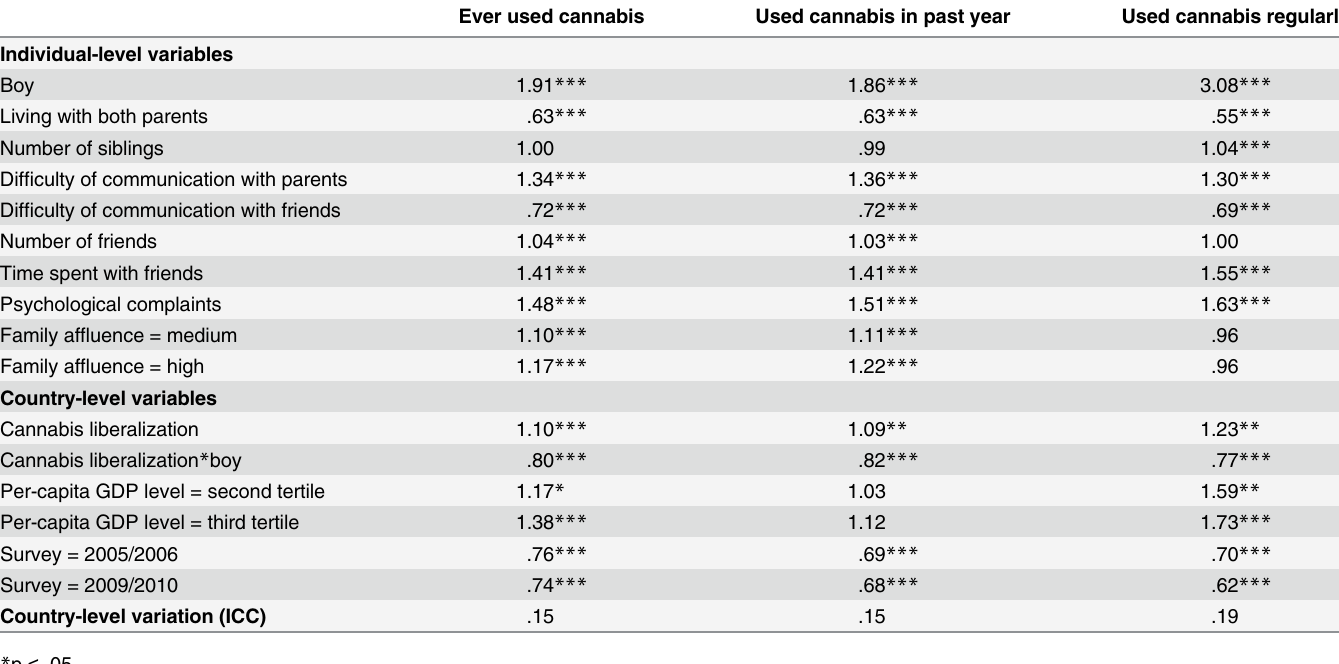
Table 3. Multilevel logistic regressions for adolescent cannabis use status and broad type of cannabis control policies. HBSC 2001 – 2010 (N =